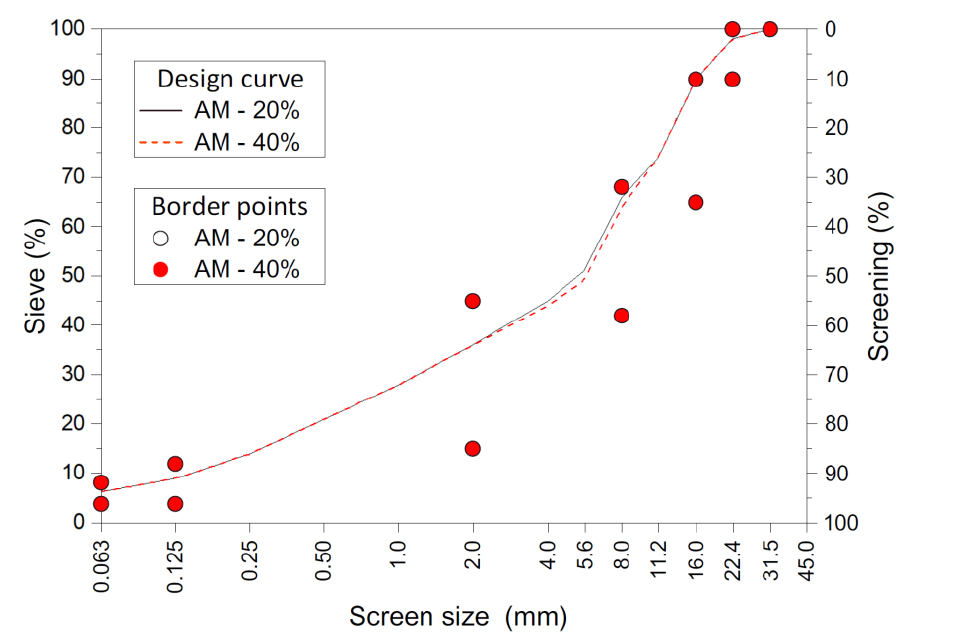
Figure 2. Grain size curves for AM-20% and AM-40%. Table 3. List of designed compositions of the